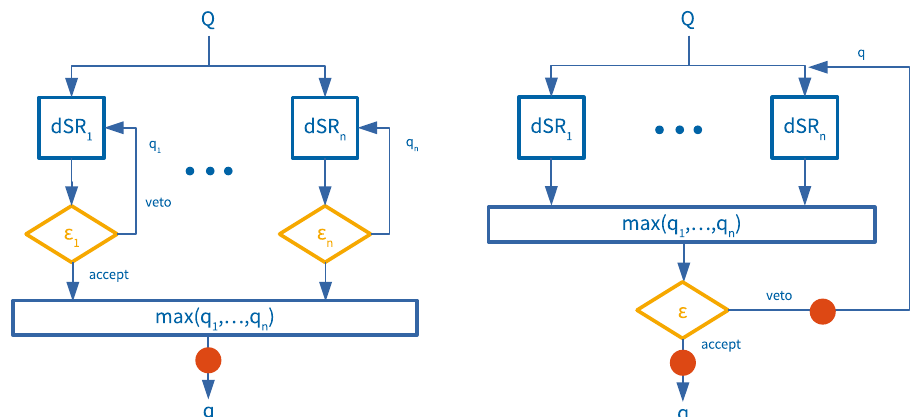
Fig. 1 Illustration of the different algorithms we consider as bench- included in the resampling, or put aside as is done in our benchmark studies. The left flow diagram corresponds to the benchmark example mark algorithms; we depict the algorithm as executed in each shower discussed, while the right flow diagram corresponds to the implemen- instance. Each d S R block corresponds to a proposal density for one i tation in the Python dipole shower. Re-entering after a veto step (the of n competing channels, (cid:5) diamonds depict the acceptance/rejection ‘veto’ branches), will start the proposal from the scale just vetoed. Note step with the weighting procedure of the Sudakov veto algorithm, and that in the first case (left), resampling is performed only after emission the selection of the highest scale within the competition algorithm. Red (or shower termination), whereas in the second case, it is performed dots indicate when the algorithm in each shower instance is interrupted after each (sometimes rejected) emission attempt and resampling in between the different showers is performed. Depend- ing on the resampling strategy, events which reached the cutoff can be